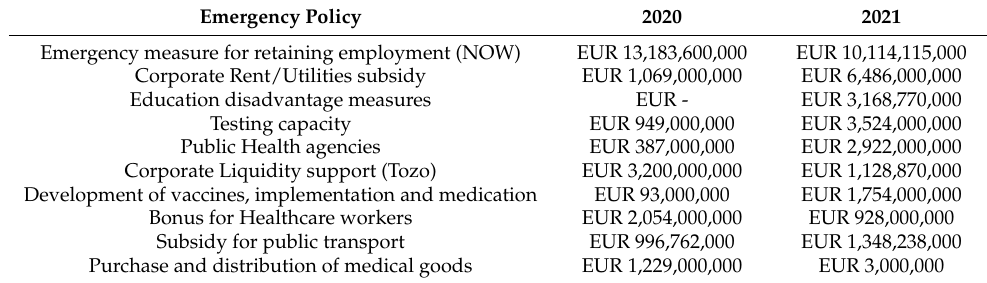
Table A7. Expenditures per year and